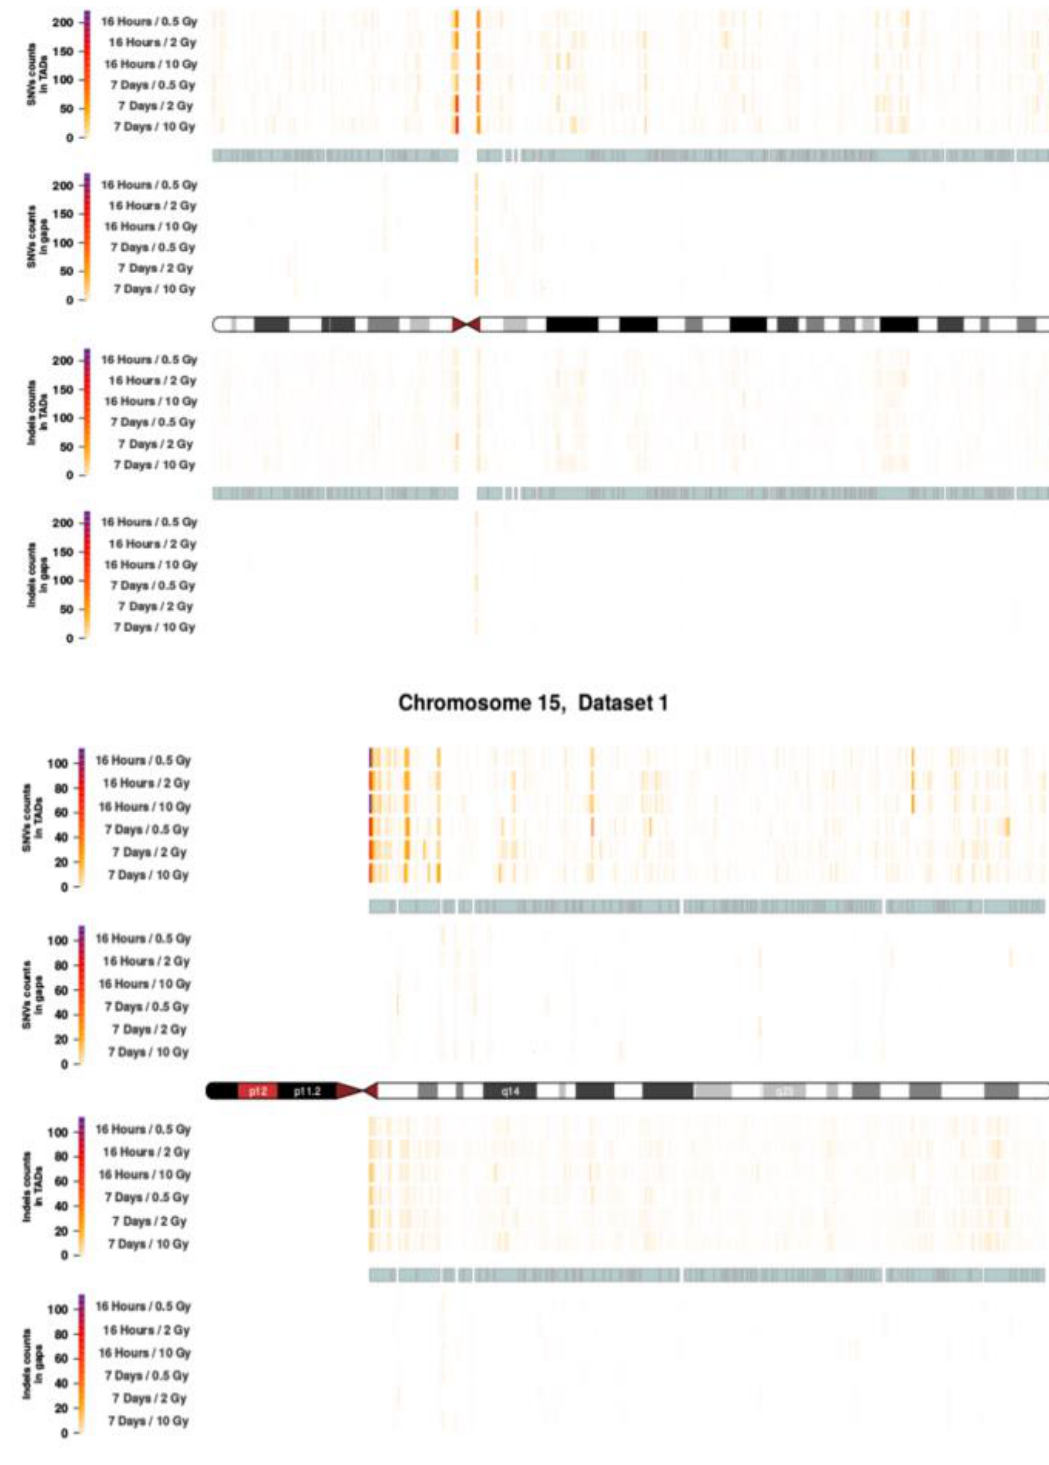
Figure A4 . Topological association domains (TADs) plot shows the distribution of SNVs (above panel) and InDels (below panel) counts over within and outside TAD coordinates for Chroosome 10 and 15 in dataset 1.